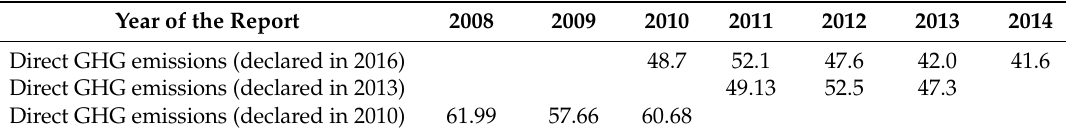
Table 8. Inconsistencies regarding the disclosure of the GHG